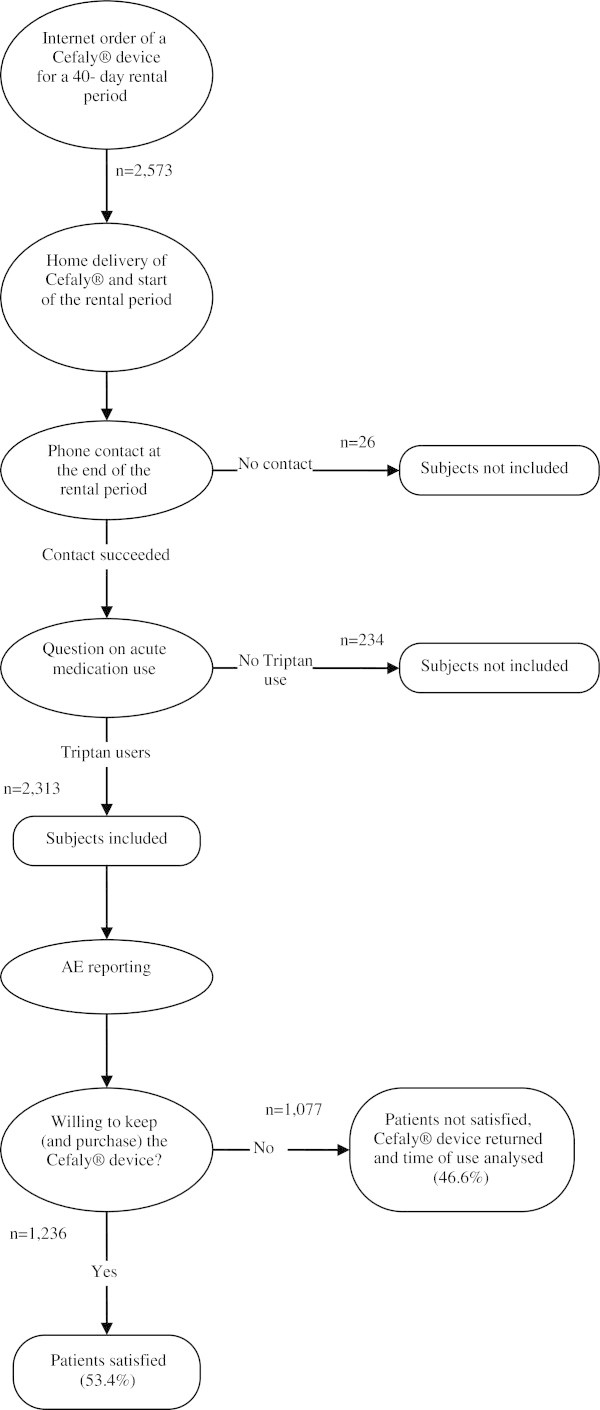
Study flow chart.